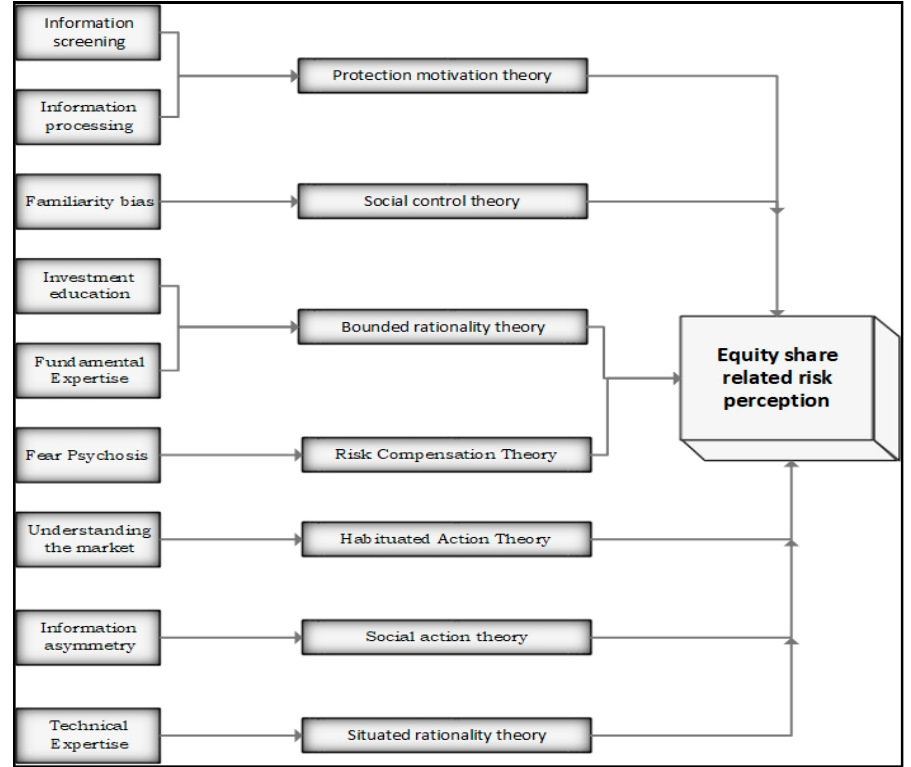
Figure 2. Factors affecting equity related risk perception along with theories. Source: Compiled by the authors from various sources.